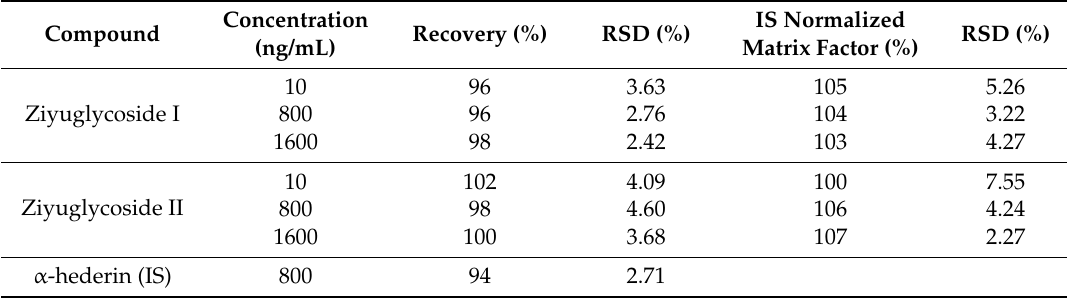
Table 5. Extraction recovery and matrix effect of ZGS1 and ZGS2 in rat plasma ( n = 5). Compound